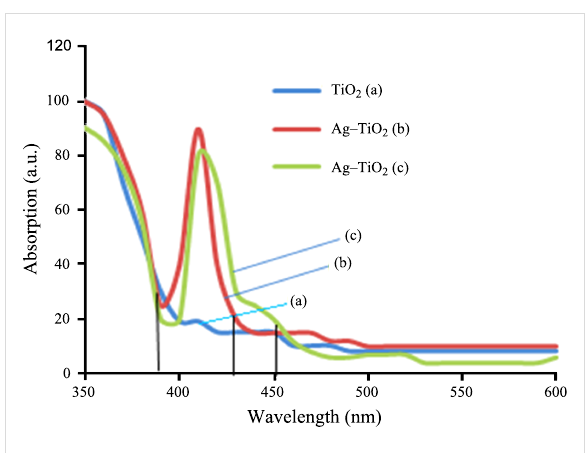
Figure 3: UV–vis absorption spectra of the annealed (a) TiO 2 and (b) 3% and (c) 7% Ag-doped TiO 2 nanoparticles.